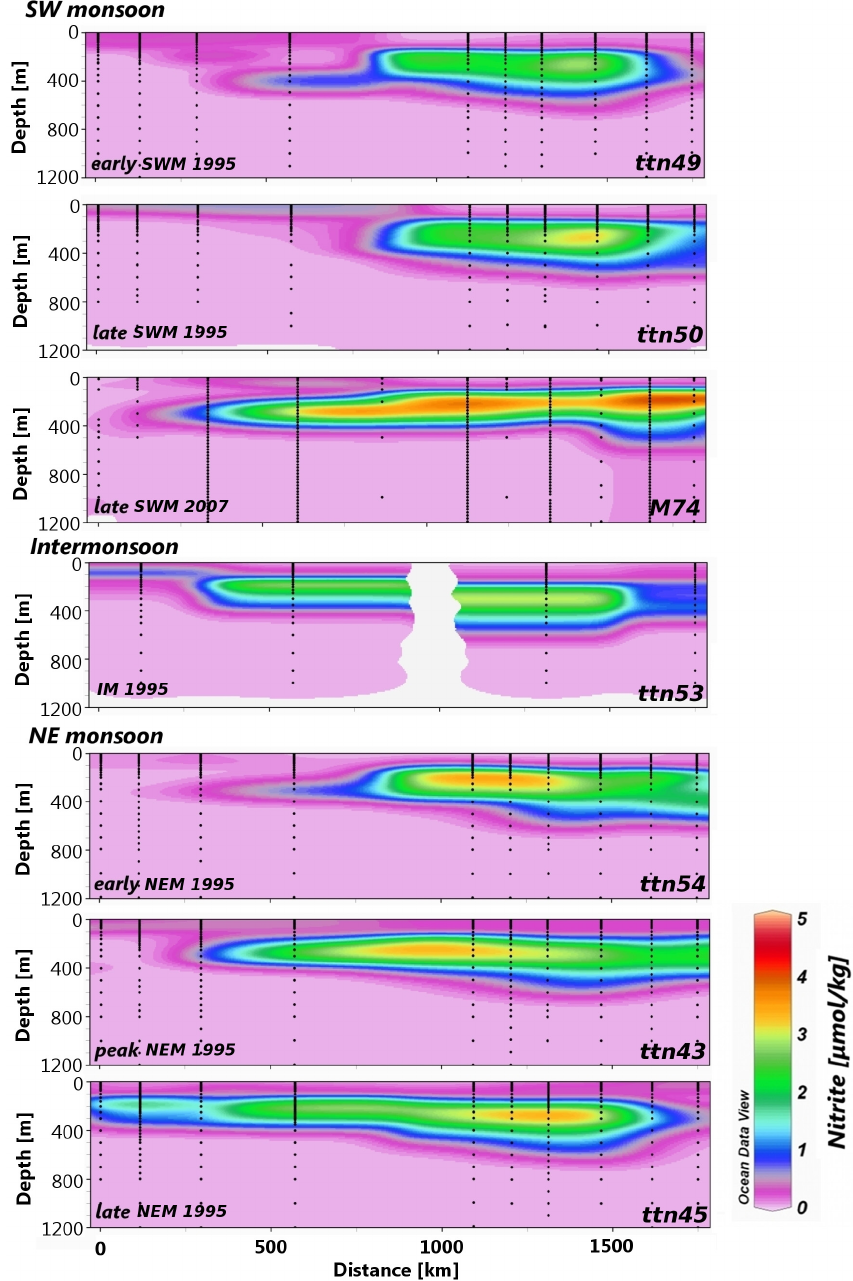
Figure 7. Cross sections showing the seasonal distribution of nitrite during the US JGOFS cruises in 1995 and the late SW monsoon 2007 (see Fig. 1 and Table 1). The transects are given in Fig. 3c and